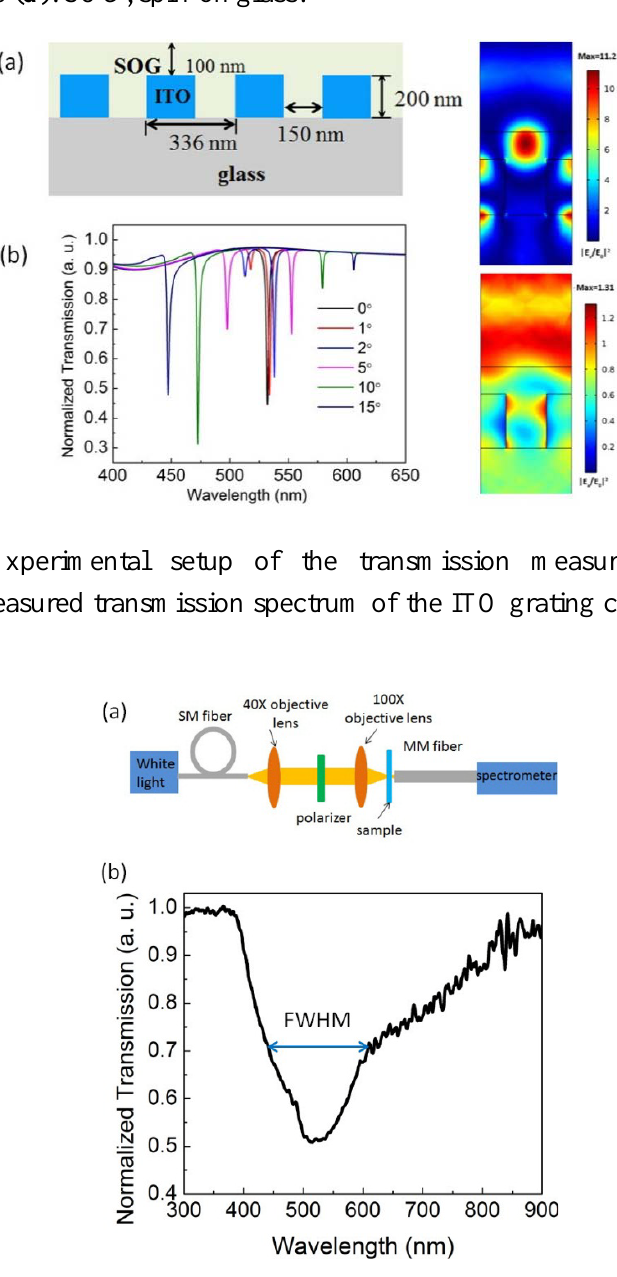
Figure 2. Schematic of the proposed guided-mode resonance (GMR) grating ( a ); the simulated optical transmission spectra of the ITO grating with different incident angles ( b ); and the electric field Ex distribution in the X–Z plane with a normal incident angle ( c ) and a 5° incident angle ( d ). SOG, spin-on glass.